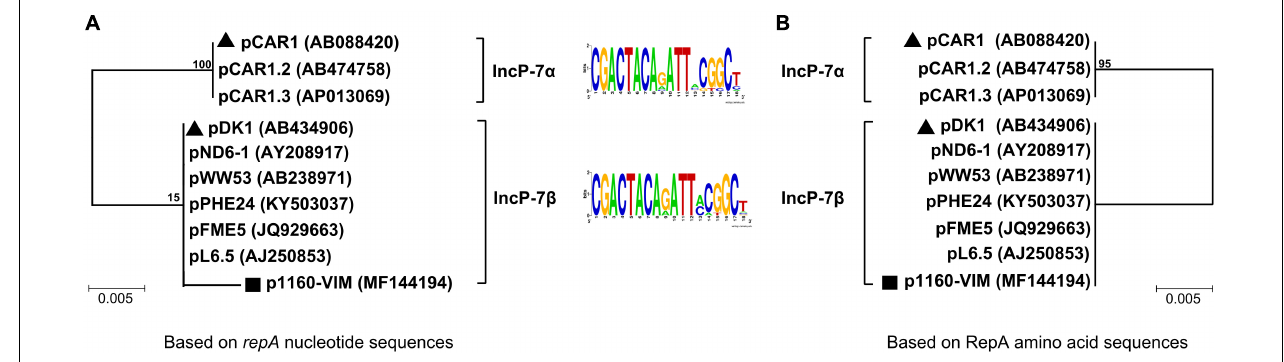
FIGURE 1 | Neighbor-joining phylogenetic trees of sequenced IncP-7 plasmids. Phylogenetic trees are constructed based on repA nucleotide (A) and amino acid sequences (B) , respectively. Degree of support (percentage) for each cluster of associated taxa, as determined by bootstrap analysis, is shown next to each branch. Triangles indicate IncP-7 α and IncP-7 β reference plasmids, while squares denote p1160-VIM sequenced in this